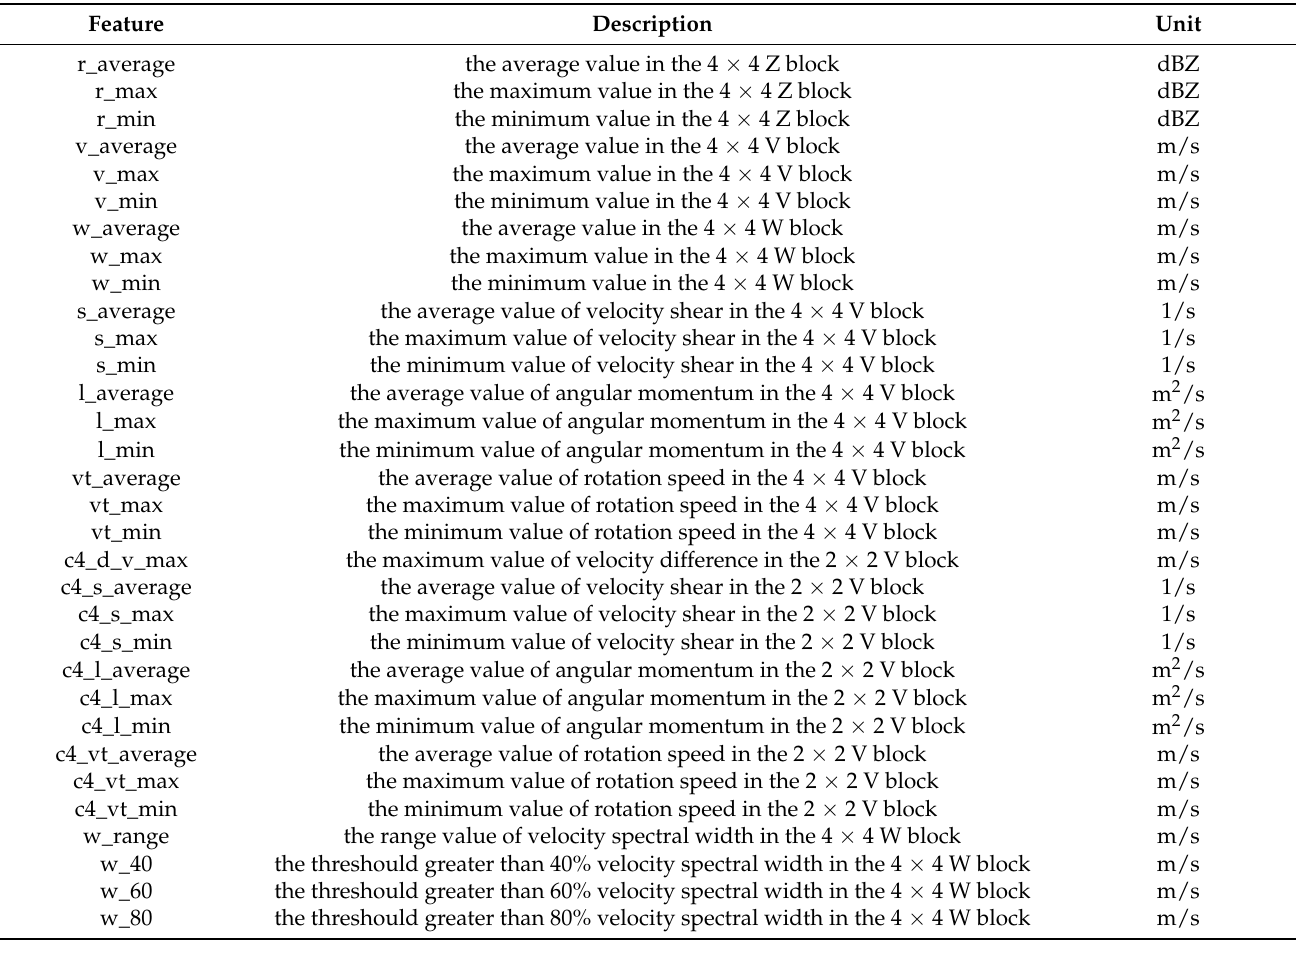
Table A1. The 32 features of the tornado sample.